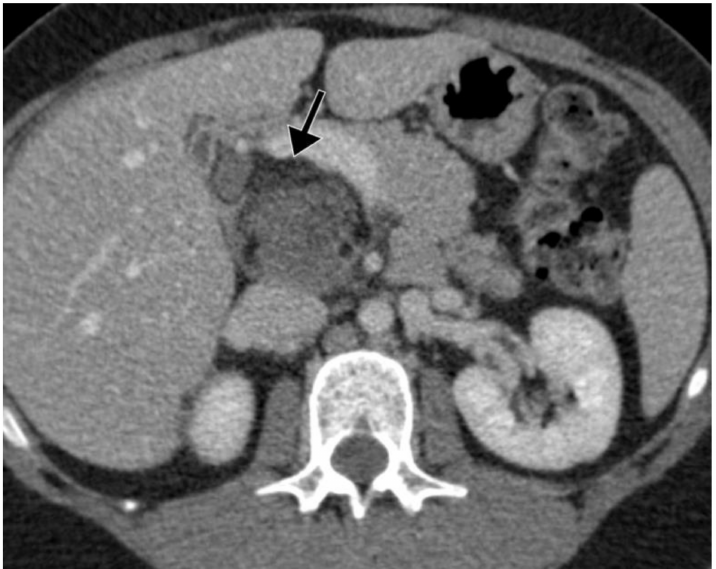
Figure 1. Contrast enhanced CT of the abdomen demonstrates a well demarcated retroperitoneal tumor posterior to the pancreatic head. Notice the presence of the macroscopic fat (black arrow), a characteristic finding consistent with